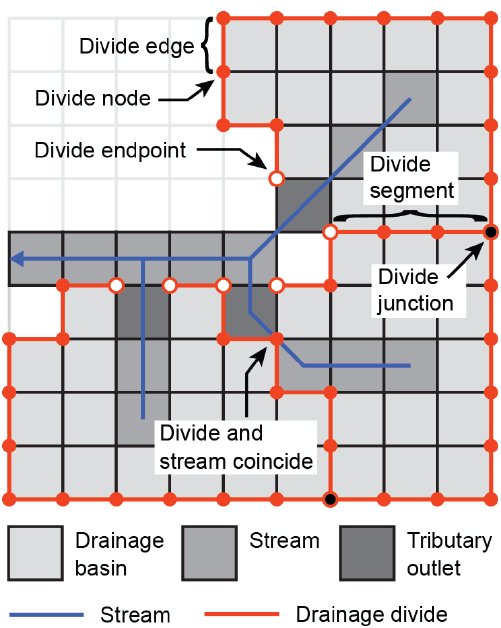
Figure 2. Definition of drainage divides in a digital elevation model. Note the point where a drainage divide (red) coincides with a river channel (blue). See text for